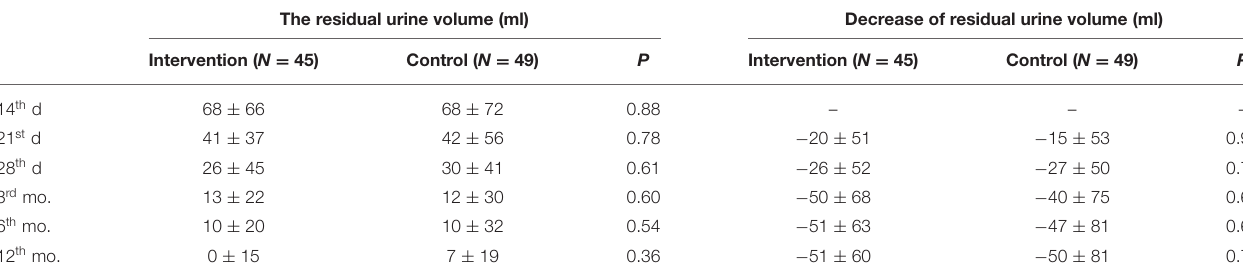
TABLE 2 | The residual urine volume at baseline and by the different periods after intervention.